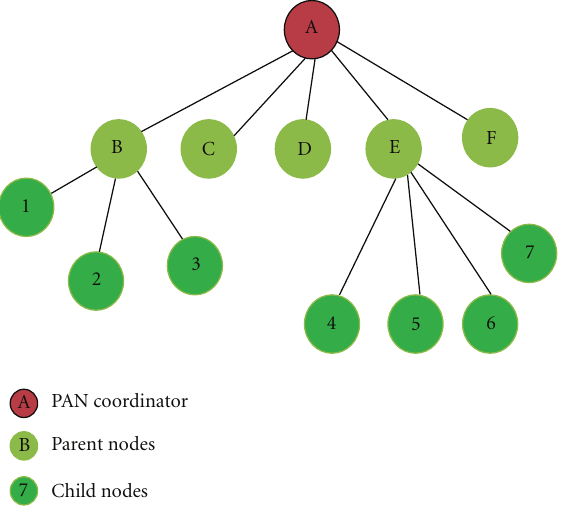
Figure 6: Di ff erent type of nodes in Hi-Low.